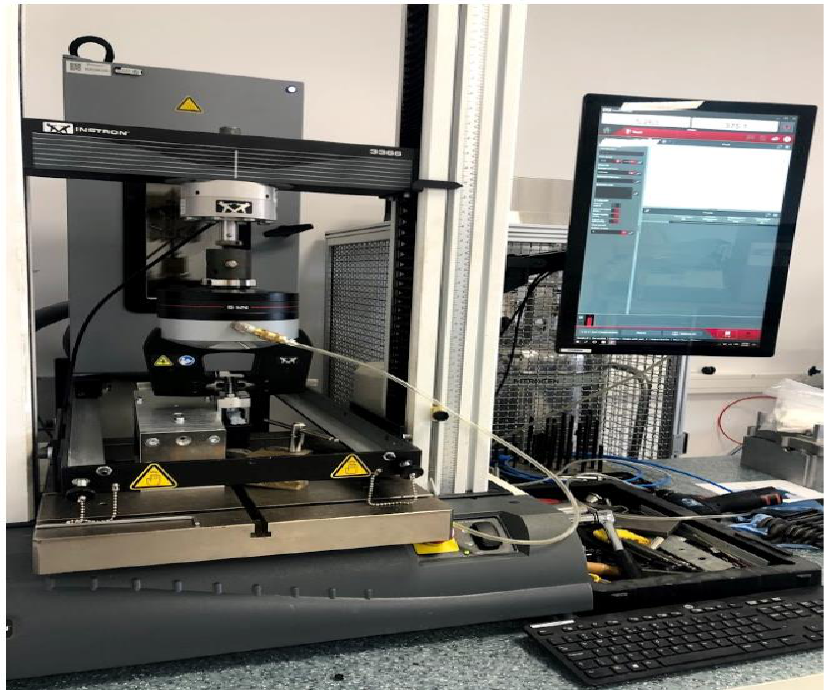
Figure 3. Setup of the testing machine, Instron 6800 Dual Column Table 68TM-30.